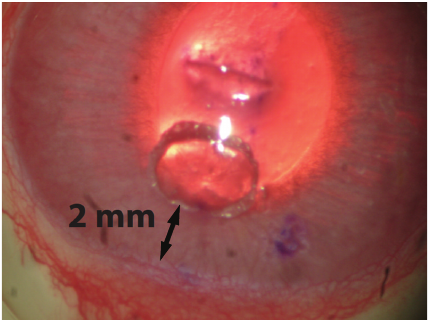
Figure 1: VEGF-induced corneal neovascularization model. Each human vascular endothelial growth factor (VEGF) polymer was inserted into surgically created corneal micropockets. Two microp- ockets, at 6 and 12 o’clock, were made from the midline incision. One VEGF polymer was placed at the end of each micropocket at a distance of 2mm from the